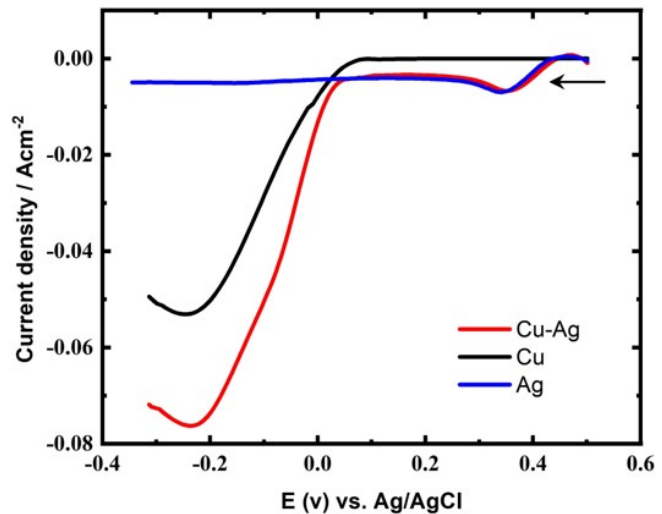
Figure 1. LSVs for Ag, Cu and CuAg reduction at GCE, sweep rate of 5 mV s − 1 , and at 27 °C.